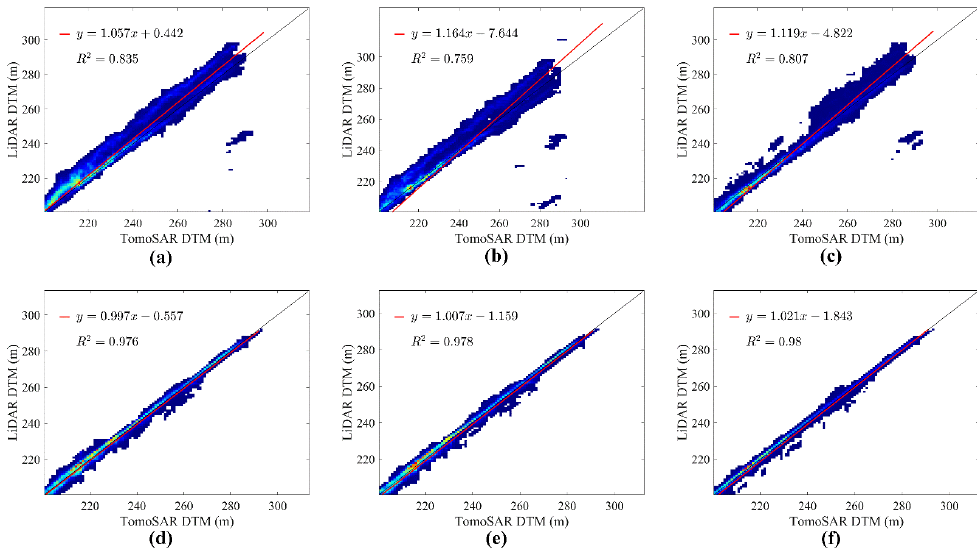
Figure 8. The 2D joint distribution between the LiDAR and TomoSAR DTM of different methods: ( a ) LiDAR DTM and DM by LM beamforming; ( b ) LiDAR DTM and DTM by LM Capon; ( c ) LiDAR DTM and DTM by LM MUSIC; ( d ) LiDAR DTM and DTM by NLM beamforming; ( e ) LiDAR DTM and DTM by NLM Capon; ( f ) LiDAR DTM and DTM by NLM MUSIC.